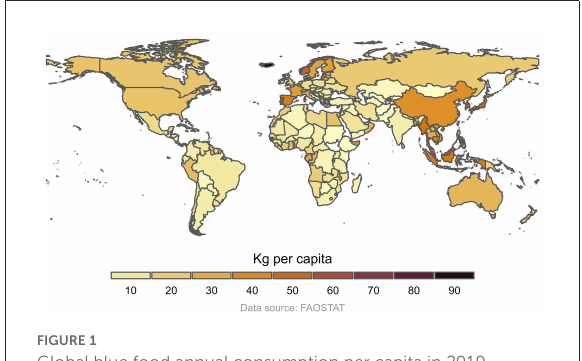
FIGURE1 Global blue food annual consumption per capita in